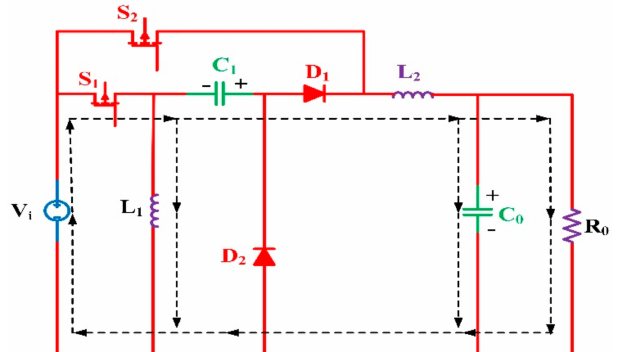
Figure 1. Proposed hybrid Zeta converter.